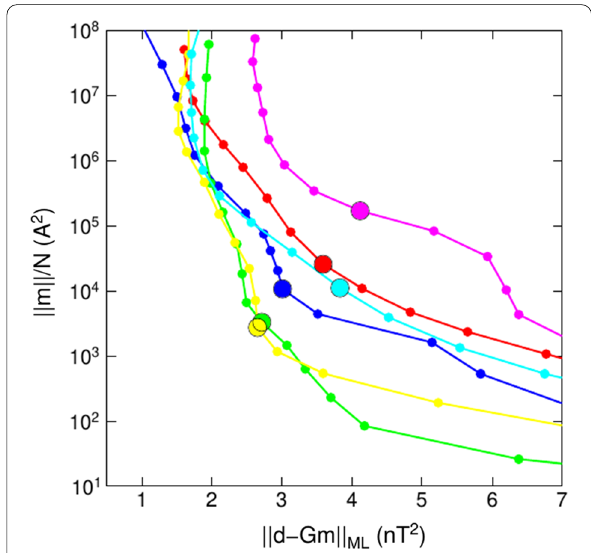
Fig. 11 The same as Fig. 9, but for the mid-latitude residuals ( d − G ˆ m ) ML . The common value of α 2 used for the analysis all Swarm data was chosen equal to α 2 = 3 × 10 − 15 nT 2 A − 2 (large